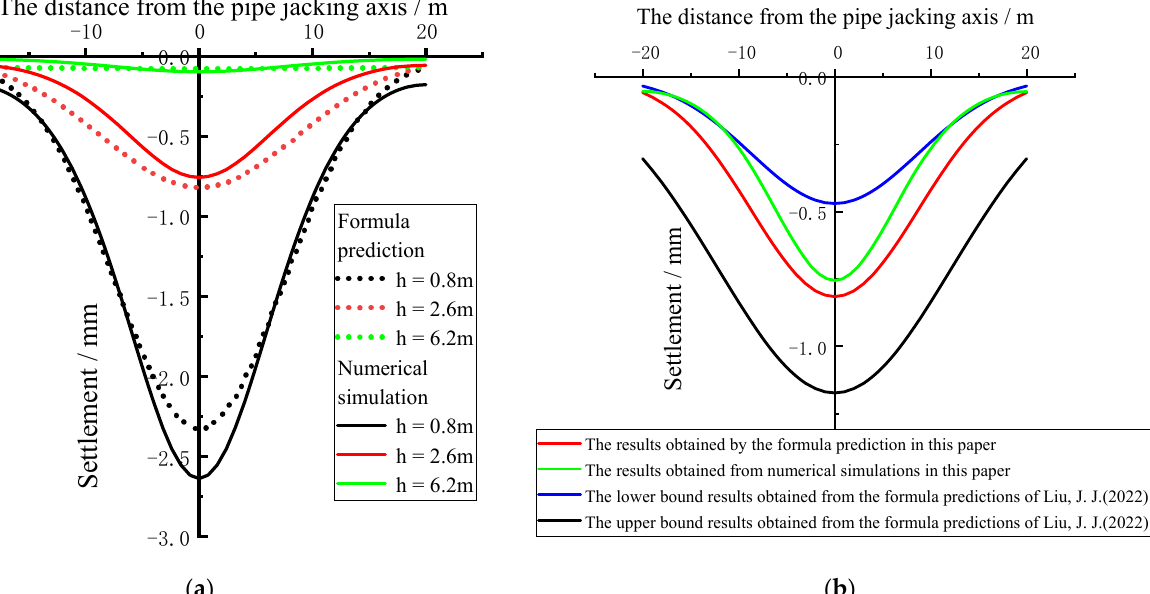
Figure 14. Comparison of ground settlement prediction. ( a ) Ground settlement comparison between modified peck formula and simulation result of pipe jacking in the soil–rock composite stratum; ( b ) comparison of ground settlement prediction in this paper with reference [27].